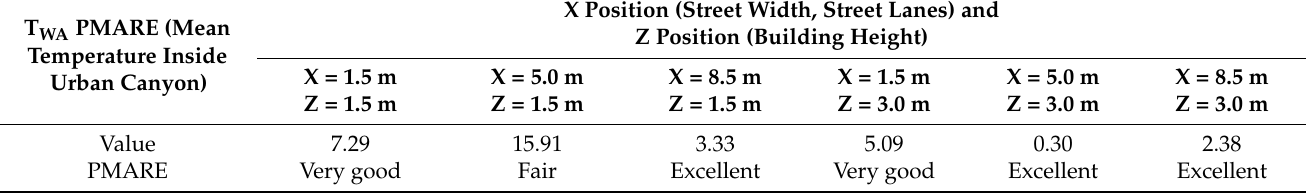
Table 3. Final values of PMARE for validation. PMARE rating for model validation is described